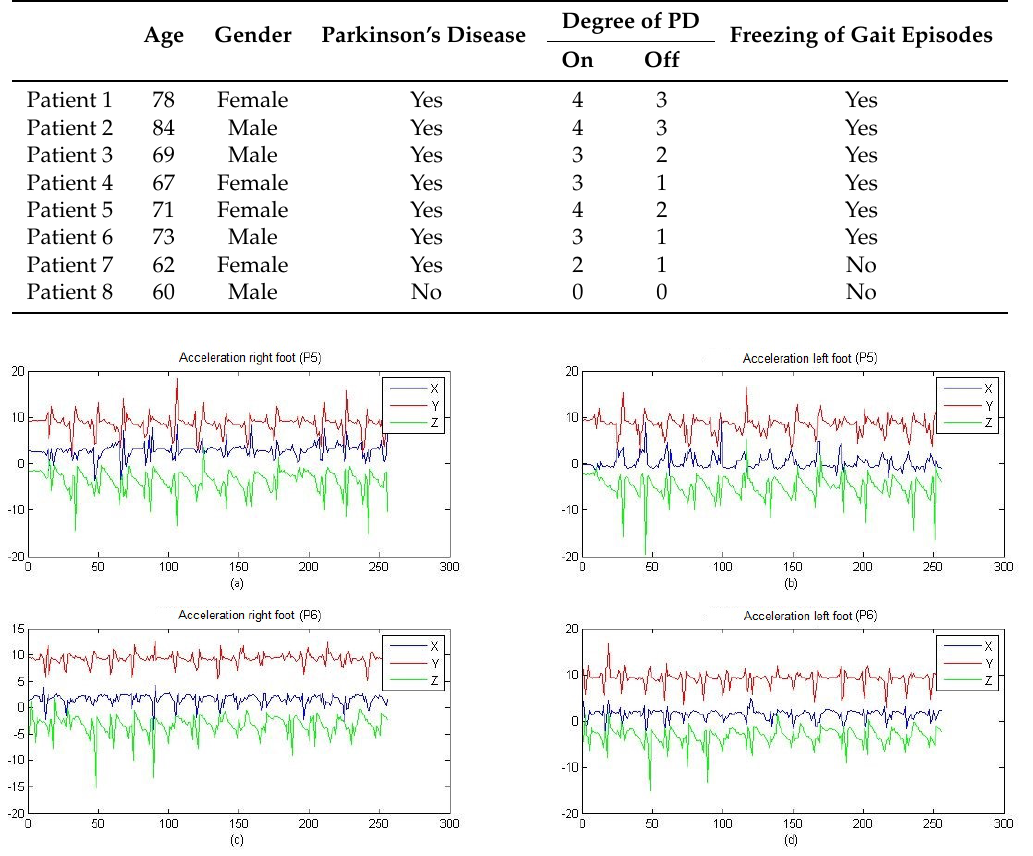
Figure 3. Acceleration in patients 5 and 6, performed in the lower